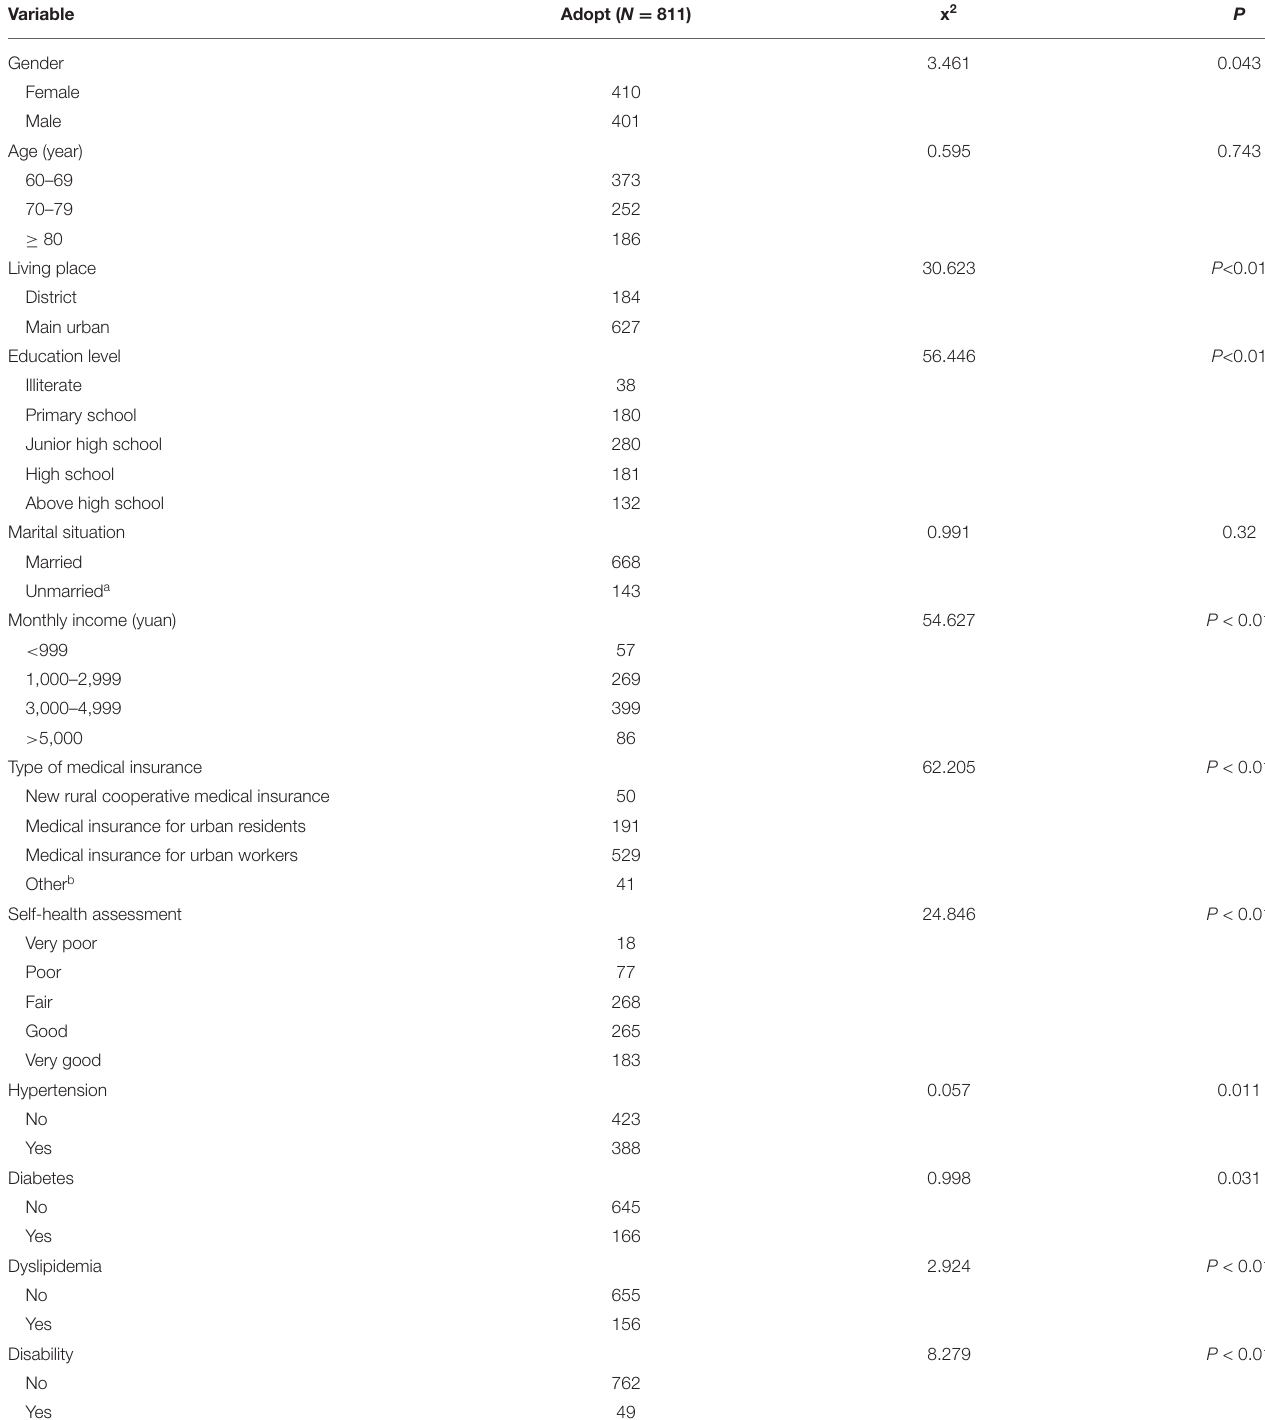
TABLE 3 | Univariate